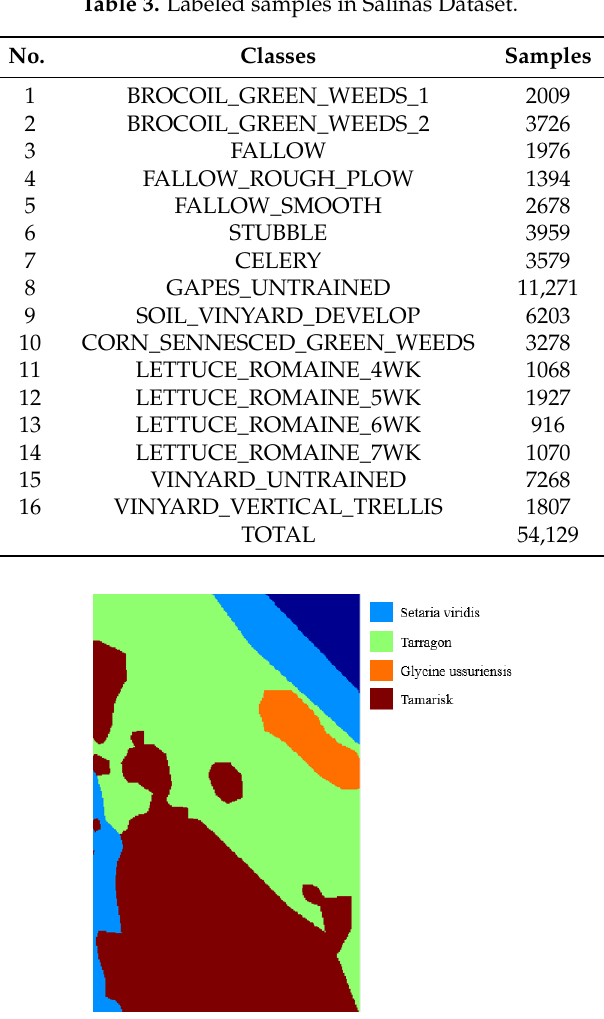
Figure 9. The groundtruth of Glycine Ussuriensis